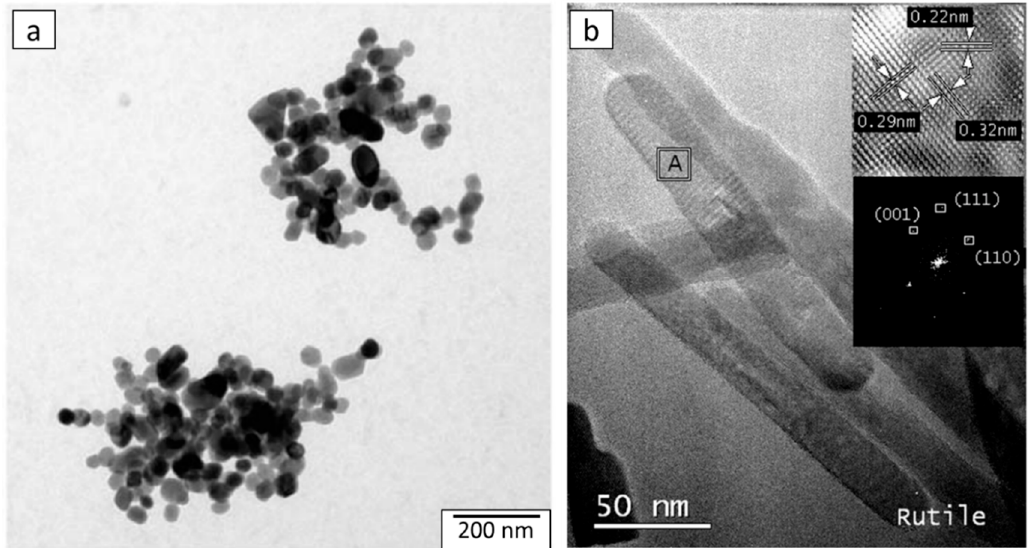
Figure 13. TEM micrographs of ( a ) TiO 2 anatase spherical sample hydrothermally treated at 230 °C from [50] (reproduced with permission from S. Hore et al., Journal of Materials Chemistry; published by RSC, 2005) and ( b ) TiO 2 rutile nanorod sample hydrothermally treated at 200 °C from [141] (reproduced with permission from H. Li et al., Materials Research Bulletin; published by Elsevier, 2011).